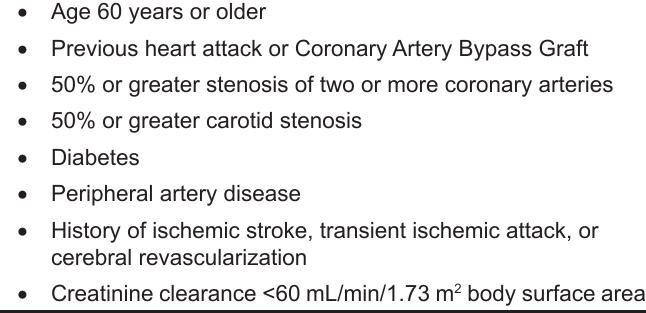
Stroke or systemic embolism per 100 patient- years of follow-up